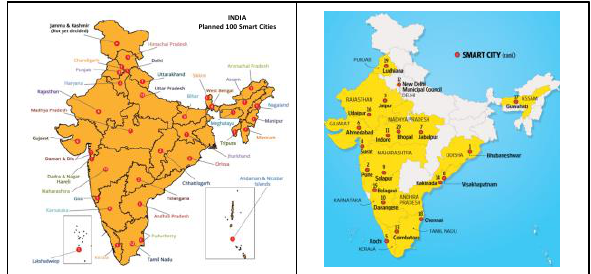
Figure 5a and 5b. Geospatial Distribution of Planned Smart Cities, India (5a); First 20 Smart Cities selected from 11 States and UT for development in India